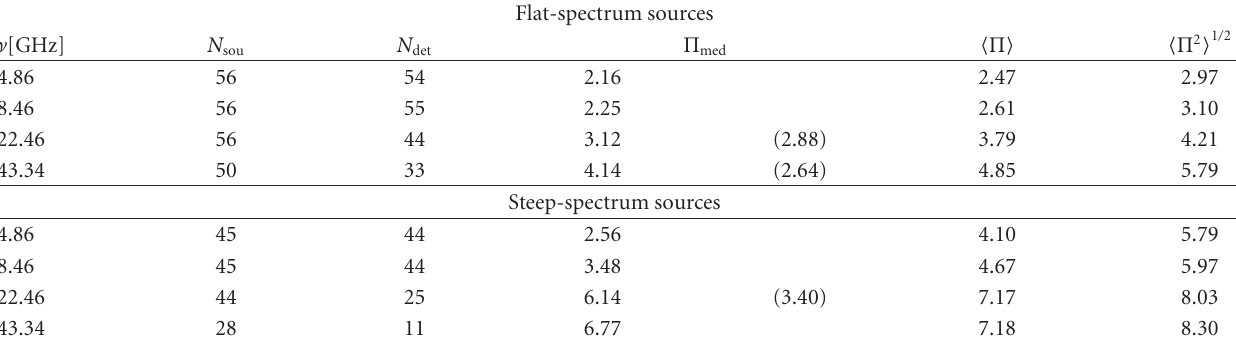
Table 2: Median and mean of the fractional polarization and (cid:9) Π 2 (cid:10) 1 / 2 from the Sajina et al. [50] sample. For flat-spectrum sources we consider only objects with S ≥ 80mJy. Median values in brackets are computed by assigning a value of Π < 1% to sources without a detection in